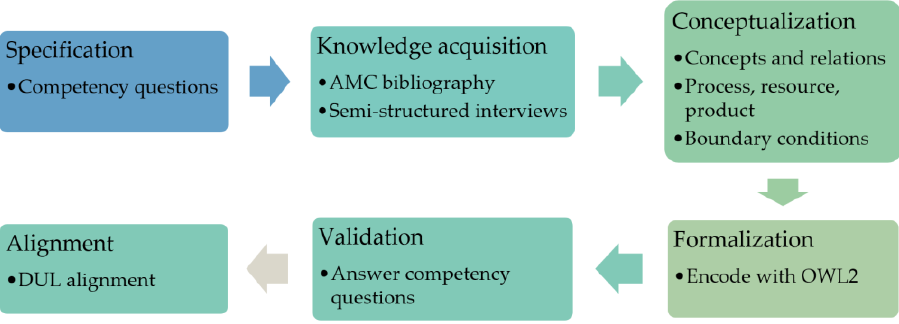
Figure 4. Ontology formalization processes.